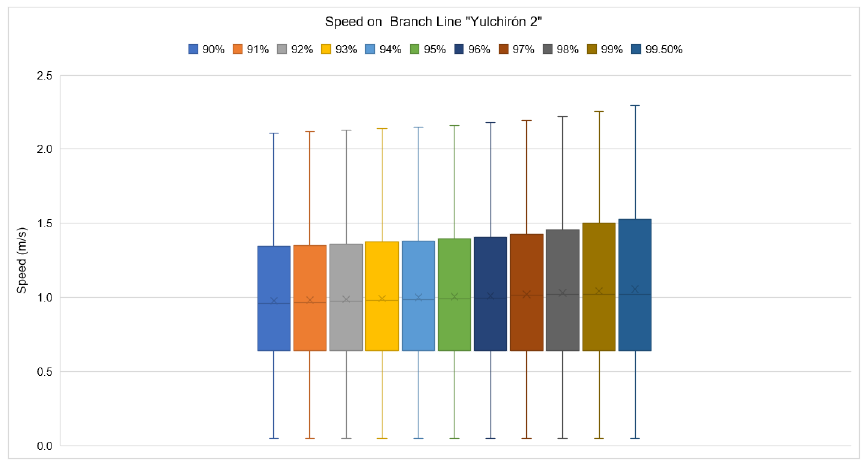
Figure 13. Speeds of the Yulchirón 2 branch line operating at demand, scenario 1.